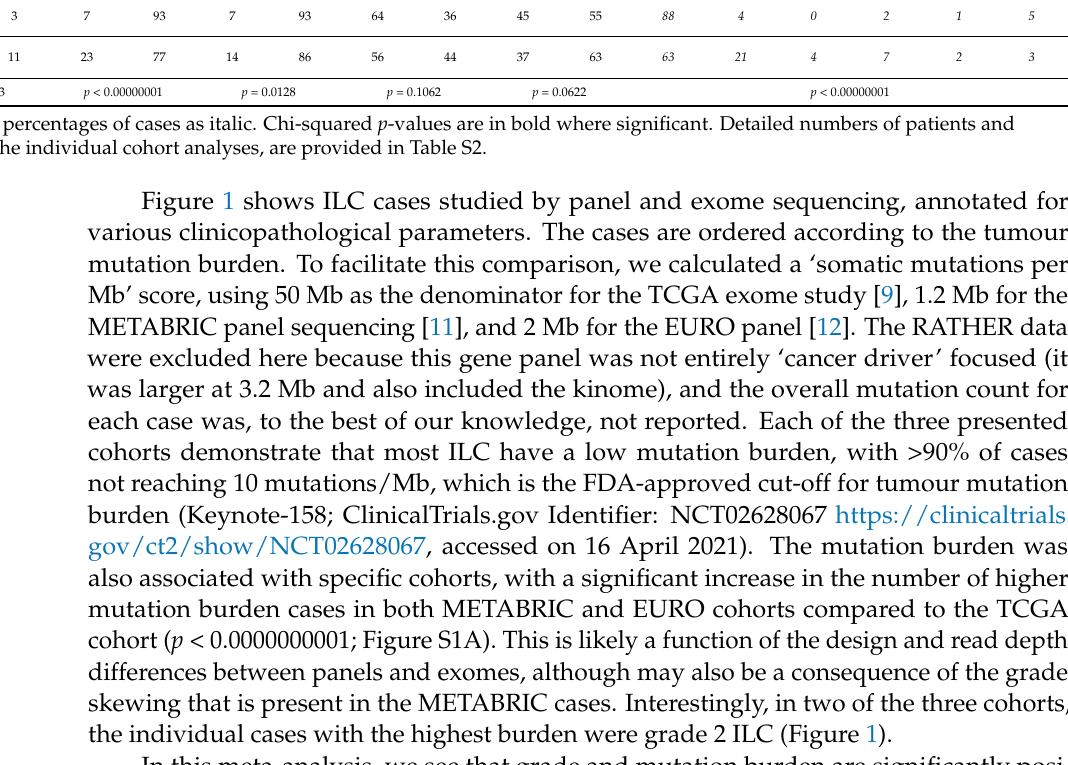
Table presented with percentages of cases as italic. Chi-squared p -values are in bold where significant. Detailed numbers of patients and proportions, as well the individual cohort analyses, are provided in Table